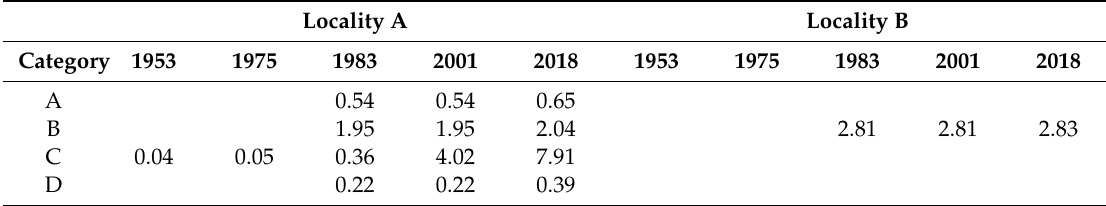
Figure 7. Proportion of individual hydrologic soil groups (HSG) types in the area of Site A ( a ) and their spatial distribution ( b ). Table 5. Absolute soil sealing by impermeable surface according to individual HSG types [ha].